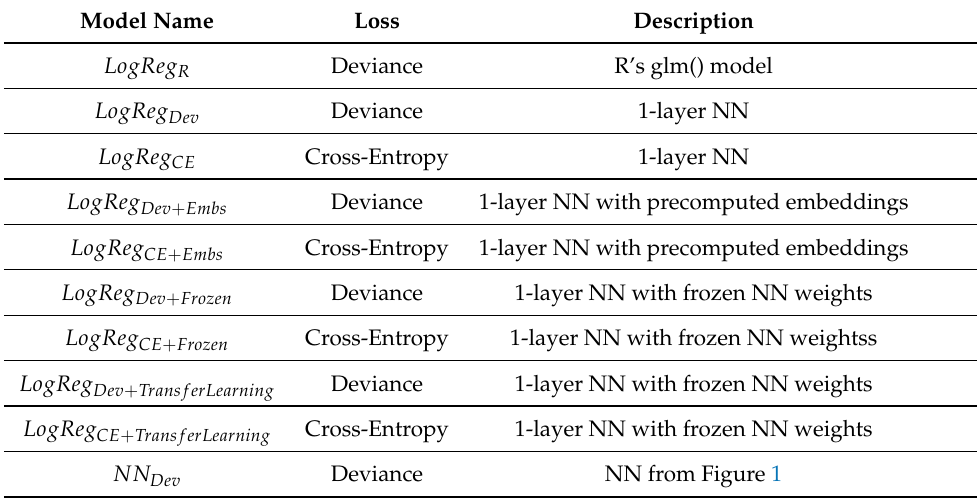
Table 3. List of models evaluated on the MTPL